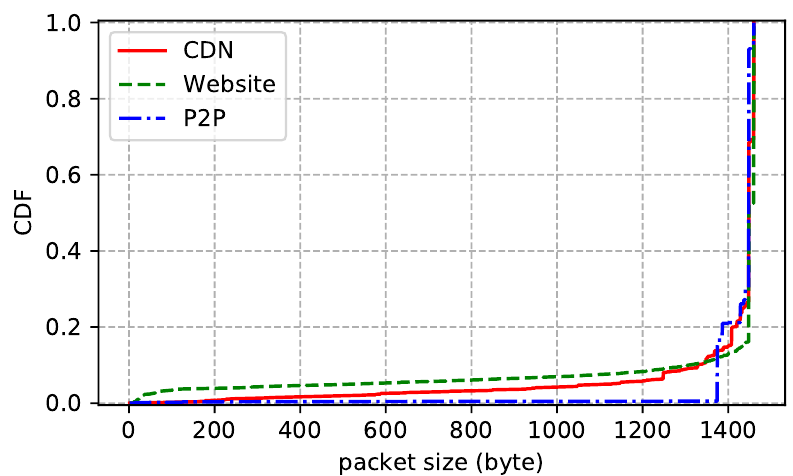
Figure 4. Flow rate distribution of each dataset.